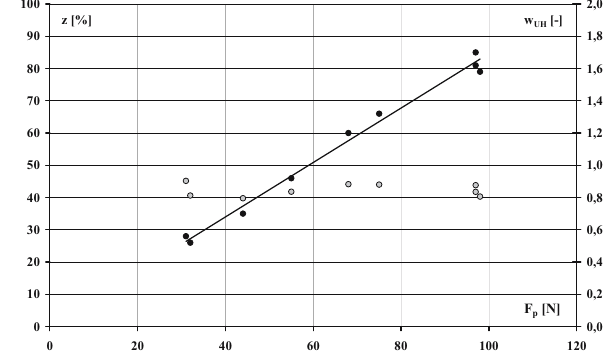
Figure 4: Dependence of the braking e ffi ciency index ( z , black color ) and a proportion ratio between the braking rate and the pressure on the brake pedal ( w UH , color gray ) on the force on the foot brake ( F p )